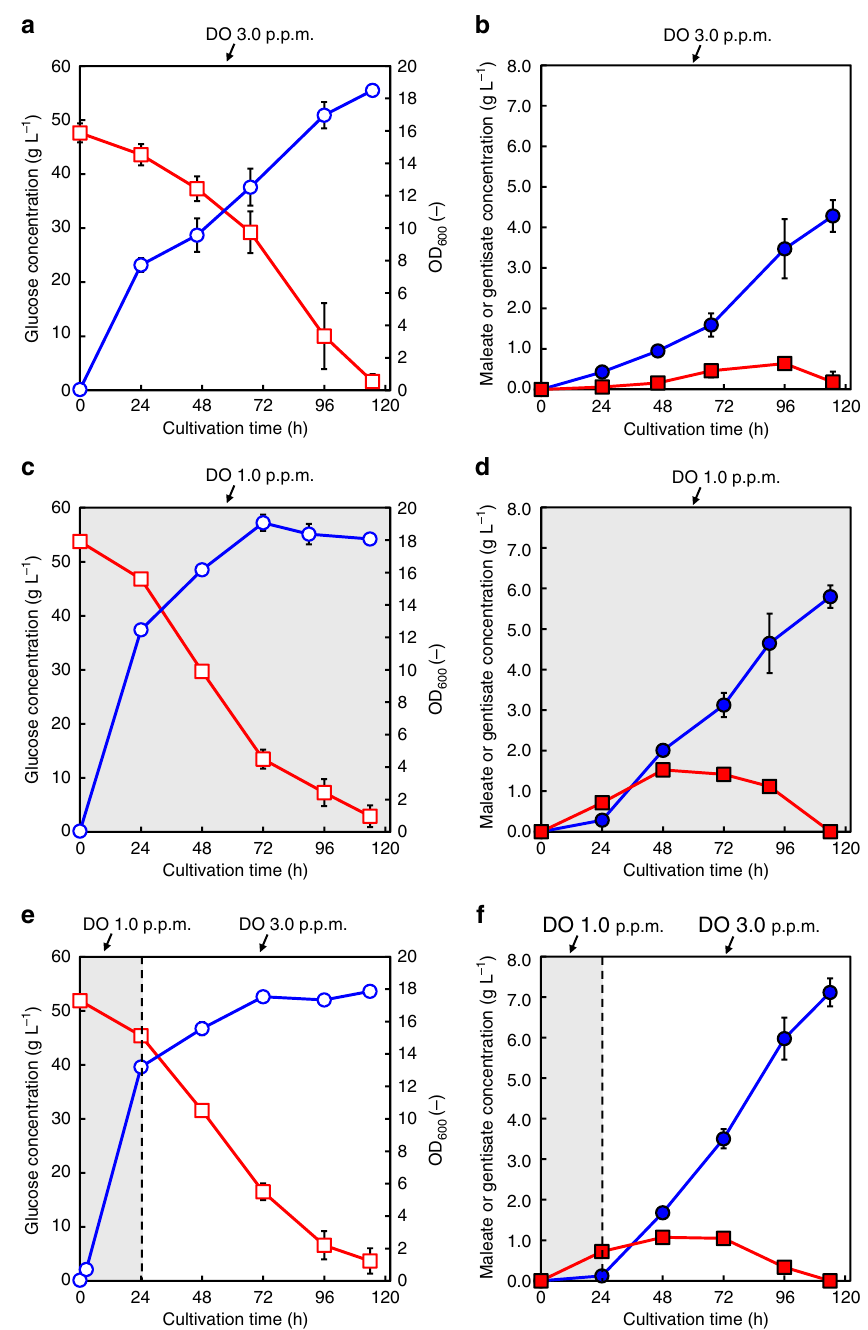
Fig. 8 Batch culture of CMtS101 in a 1-L jar fermentor under three different DO conditions. Time courses of a , c and e the bacterial cell growth (circles) and glucose concentration (squares), and b , d and f the amount of produced maleate (circles) and gentisate (squares). Data are presented as the mean ± standard deviation of three independent experiments ( n =